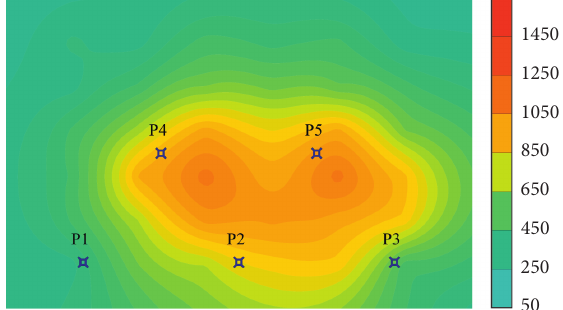
Figure 11: Polymer concentration field during binary flooding with strong edge water (0.6PV).